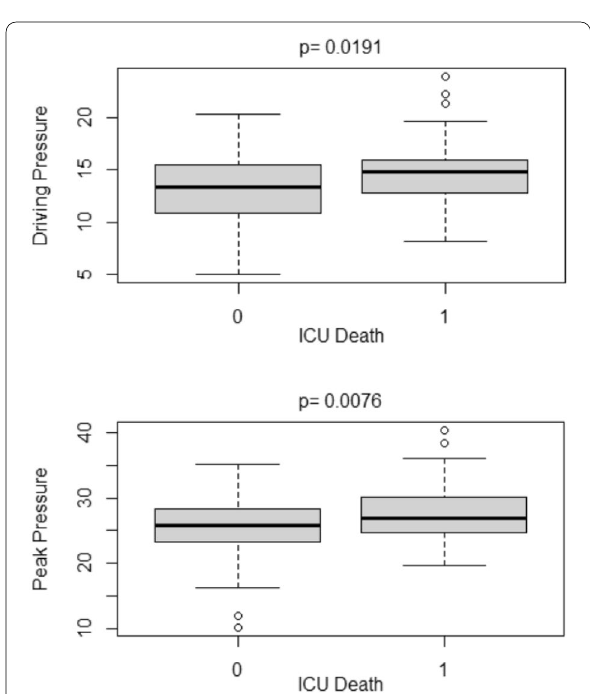
Fig. 4 Boxplots of mean DP and mean peak pressure during ECMO according to ICU survival. 0 ICU survival, 1 ICU death, DP driving pressure, ICU intensive care